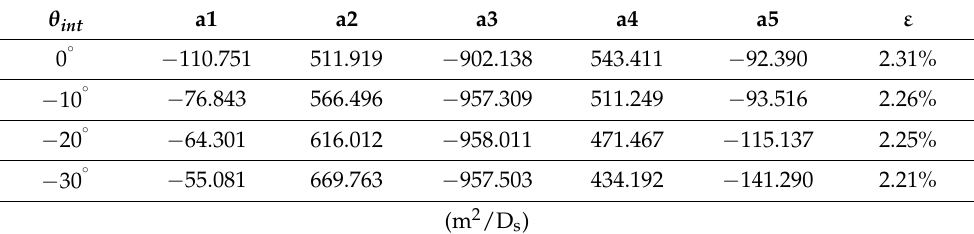
Figure 13. The schematic diagram for the five zones of shoreline retreats and advance. Table 3. The amount area of shoreline retreats and advance for different angles of incident